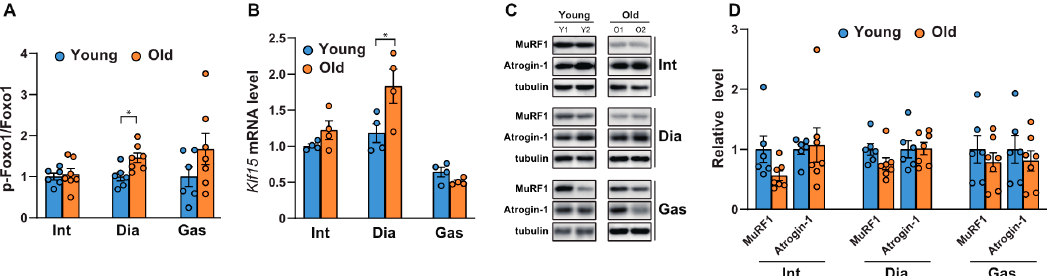
Figure 2. Comparison of the phosphorylation of FoxO1 and the expression levels of Klf15 and ubiquitin-related proteinases between the respiratory muscles and gastrocnemii with age. ( A , C ) Each muscle was lysed and analyzed by Western blotting ( n = 6). The relative intensities of the bands were quantified using ImageJ analysis software ( n = 6). Data are displayed for pSer256-FoxO1 compared to those for FoxO1. ( B ) The muscles were lysed and subjected to RT-qPCR analysis ( n = 6). Rat glyceraldehyde 3-phosphate dehydrogenase ( Gapdh) was used to normalize gene expression. ( D ) The relative intensities of the bands were quantified using ImageJ analysis software ( n = 6). MuRF1 and Atrogin-1 levels are both shown in comparison with tubulin levels. The data are shown as the mean ± standard deviation. Statistical analysis was performed using unpaired Student’s t-test. * p < 0.05; 6-month-old versus 20-month-old rat muscles. Abbreviations: diaphragm muscle (Dia); gastrocnemius muscle (Gas); intercostal muscle (Int); 6-month-old rat (Young); 20-month-old rat (Old).